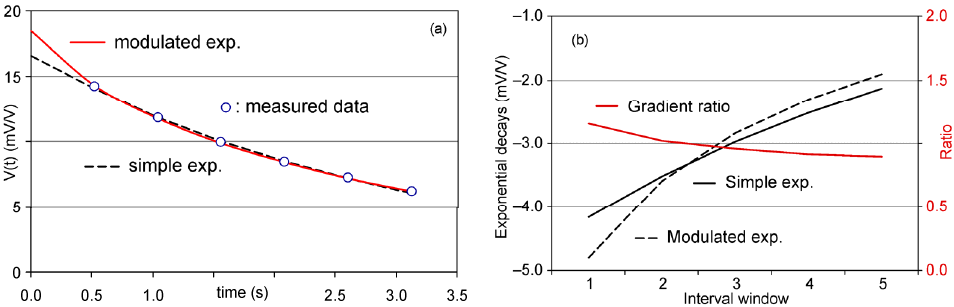
Figure 3. ( a ) Approximation exponentials. ( b ) Derivative curves and their ratios.